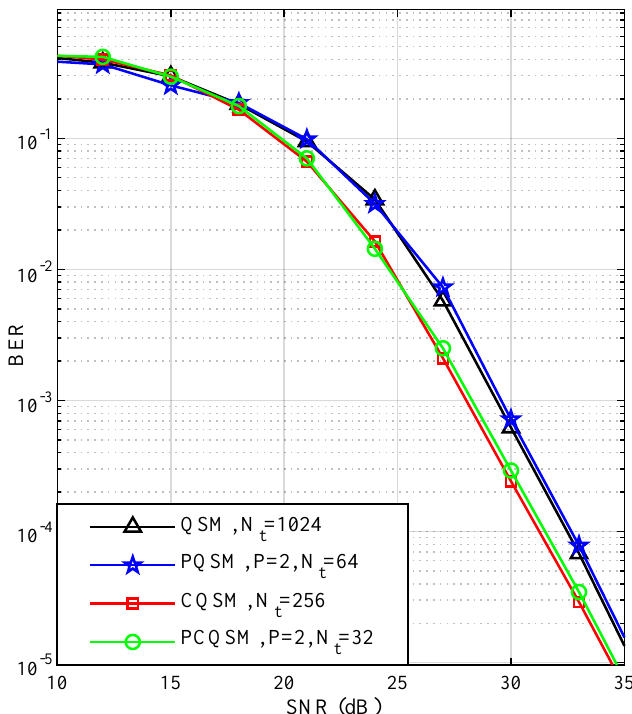
Figure 5. Performance comparison of SM schemes with transmission rate of 24 bits/s/Hz with N r = 4 and modulation order, M =